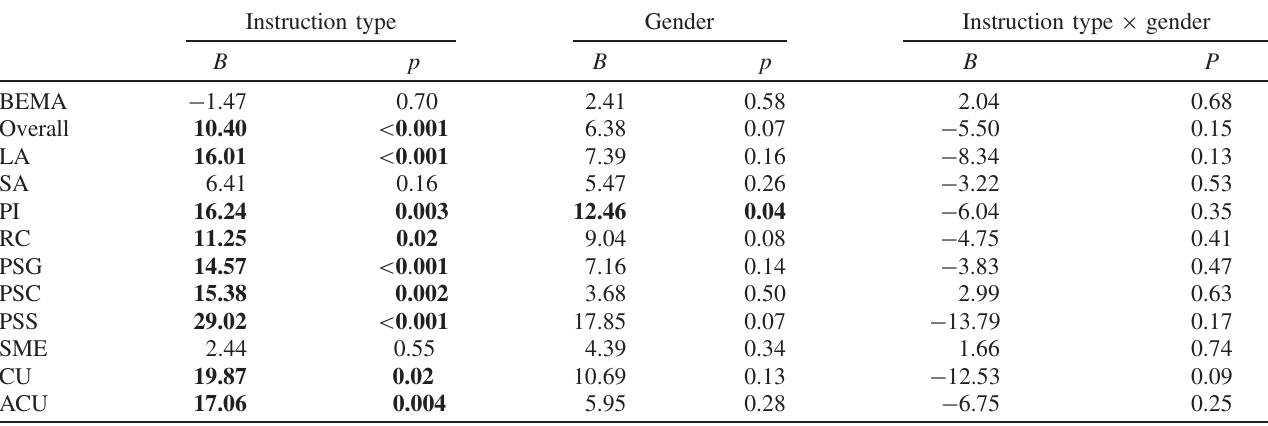
TABLE VIII. Unstandardized regression coefficients for the whole-year CLASS and BEMA. Bold cells indicate a significant effect ( p < 0 . 05